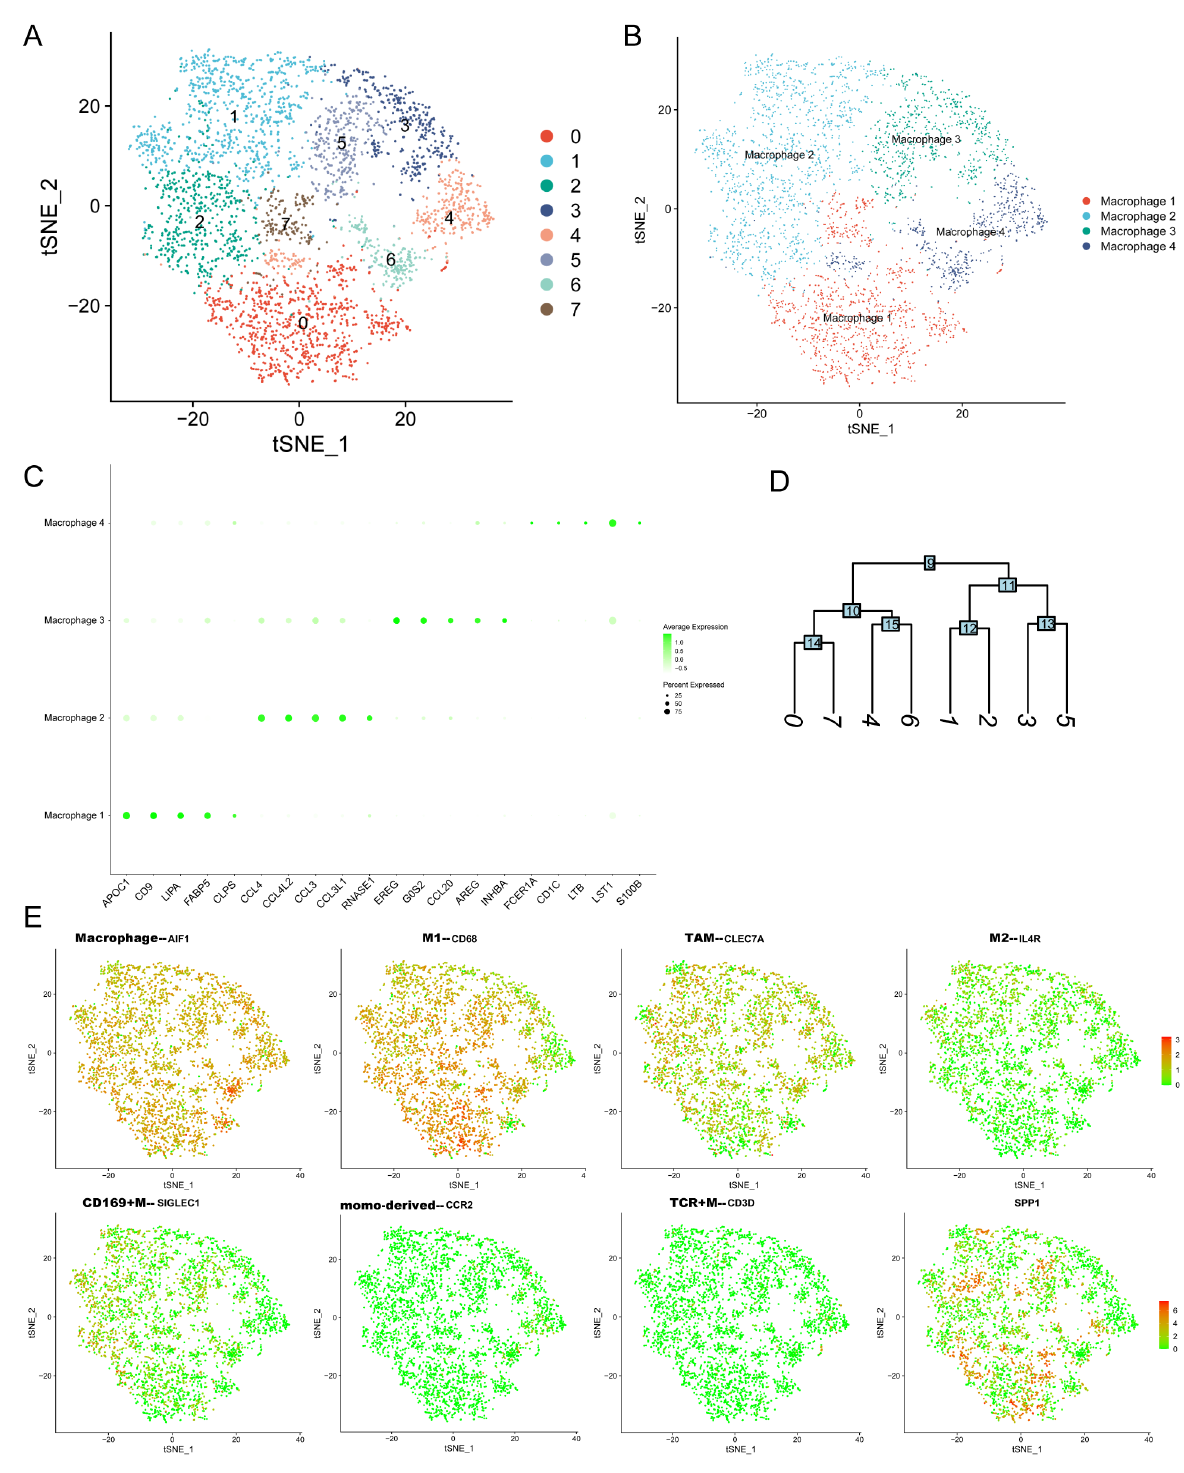
Figure 5. The expression of SPP1 among distinct macrophage subpopulations. ( A , B ) The t-SNE plots showing the original cluster ( A ) and named macrophage subpopulations; ( C ) dot plot showing the top 5 marker genes across macrophage subpopulations (size of dots represents the proportion of cells expressing a particular marker, and the intensity of color indicates the average expression level); ( D ) clustering diagram showing the similarity of clusters; ( E ) the expression levels of markers of many macrophage subtypes are shown in t-SNE plot (red and green dots represent high and low expression